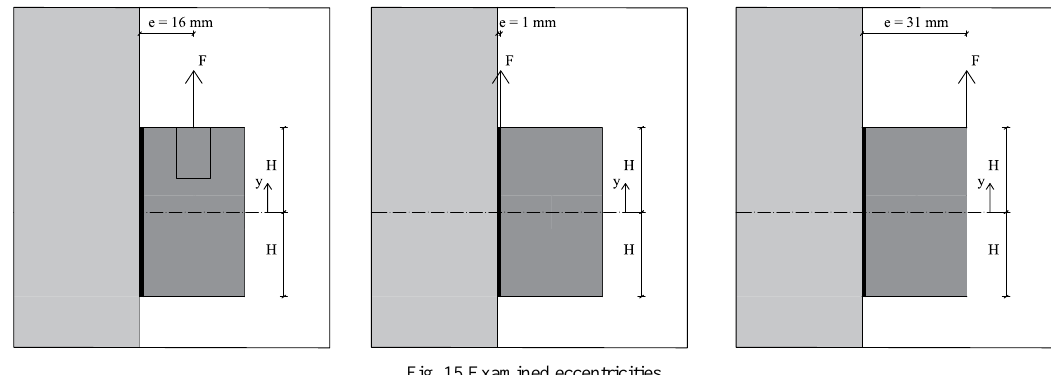
Fig. 15 Examined eccentricities